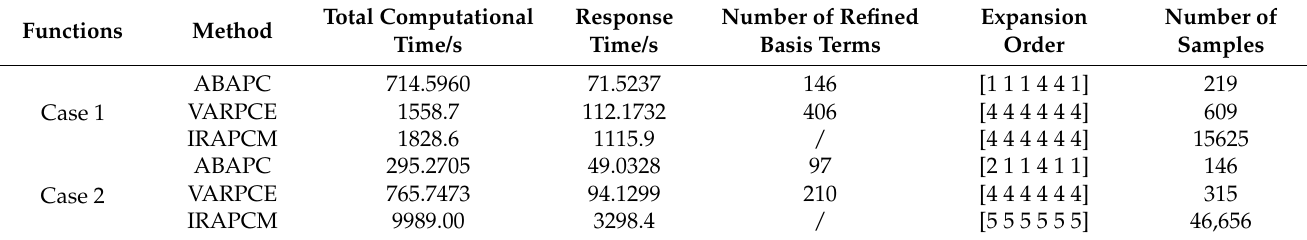
Table 4. Comparison of calculation results obtained by ABAPC, VARPCE, and